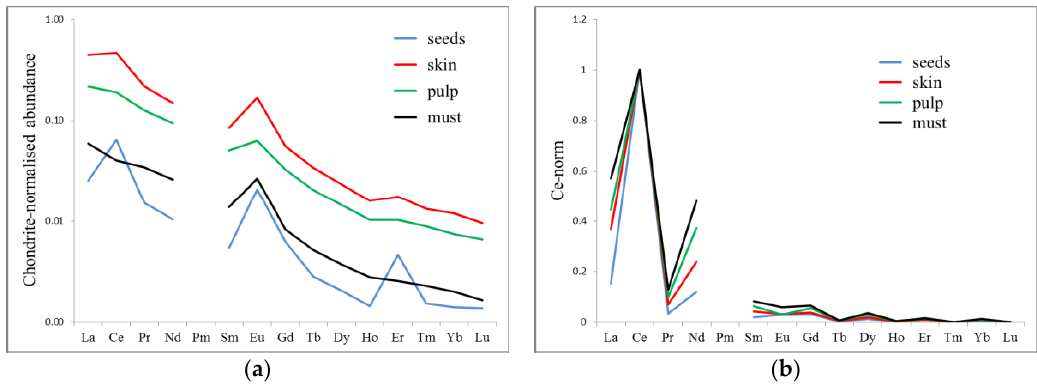
Figure 2. Distribution of REEs in the different parts of Primitivo grapes and in must: ( a ) chondrite-normalized values; ( b ) Ce-normalized values.